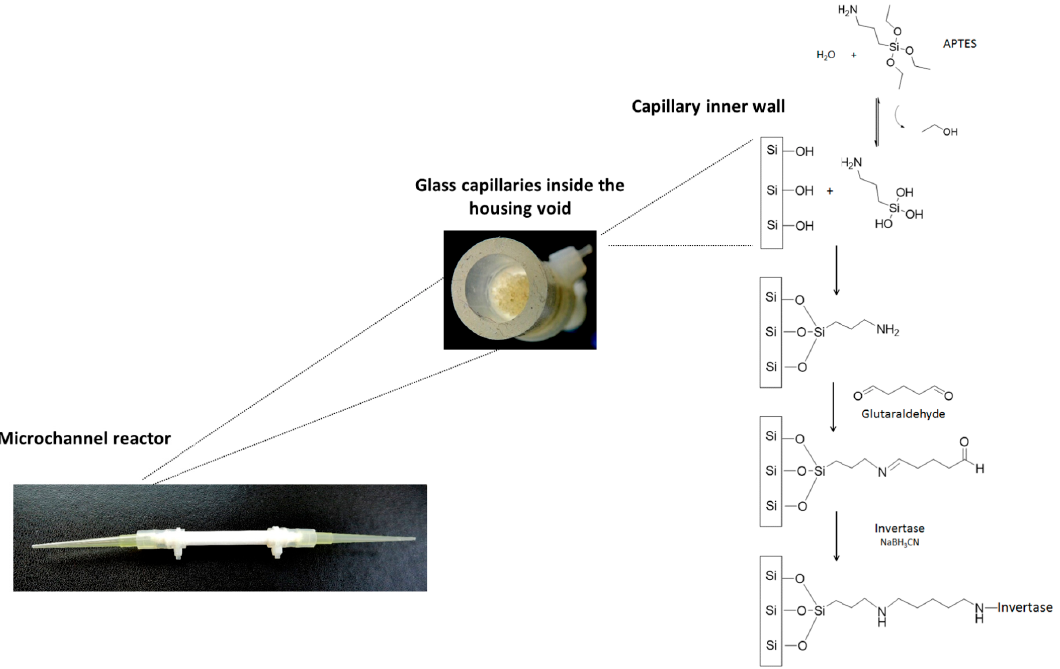
Figure 9. Microchannel reactor scheme and invertase immobilization methodology. The microchannel reactor constituted by an array of 40 glass capillaries placed within a poly(methyl methacrylate) housing